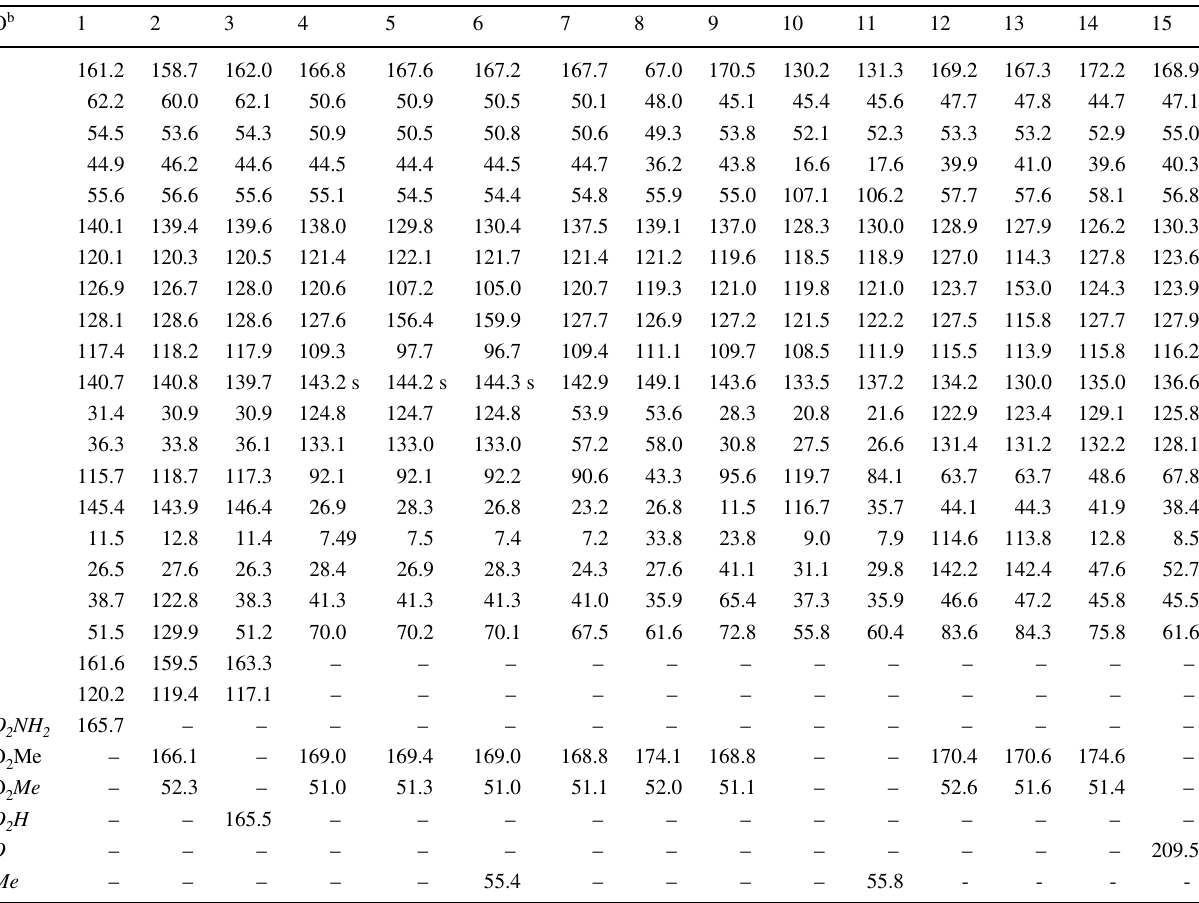
Table 5 C NMR spectroscopic data of compounds 1 – 15 (δ in ppm)